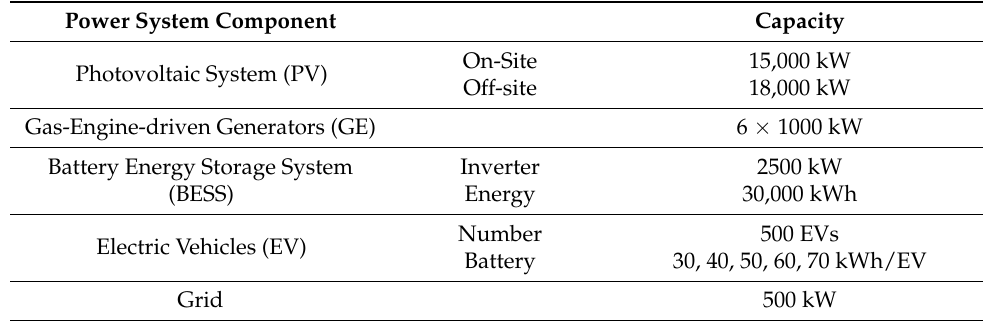
Table 1. Specifications of power system